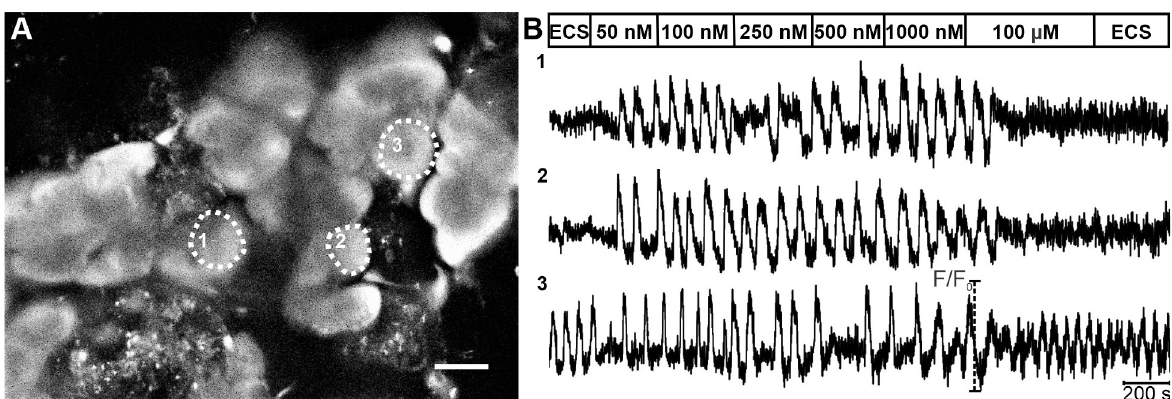
Fig 3. [Ca 2+ ] i oscillations in acinar cells upon stimulation with a ramp of ACh concentrations. (A) OGB-1 loaded acinar cells in a tissue slice. Scale bar 20 μ m. (B) [Ca 2+ ] i oscillations shown here belong to the acinus marked with thin broken line and the corresponding number in (A). At the beginning and end of the protocol, extracellular solution (ECS) was used (see Materials and Methods). On average, after stimulation with 100 μ m ACh, a biphasic [Ca 2+ ] i response with a rise in basal [Ca 2+ ] i level was seen in 98.5% of acinar cells. Note that in cell 3, spontaneous [Ca 2+ ] i activity was observed prior to stimulation, whereas cells 1&2 lacked spontaneous